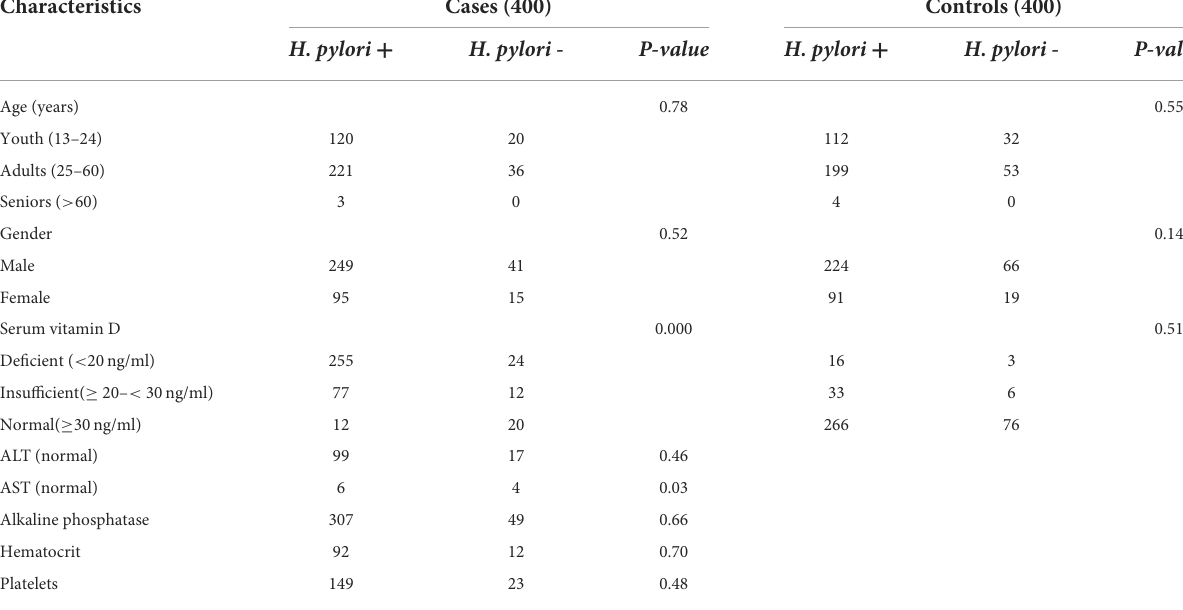
TABLE 1 Baseline characteristics and vitamin D levels of cases and controls.